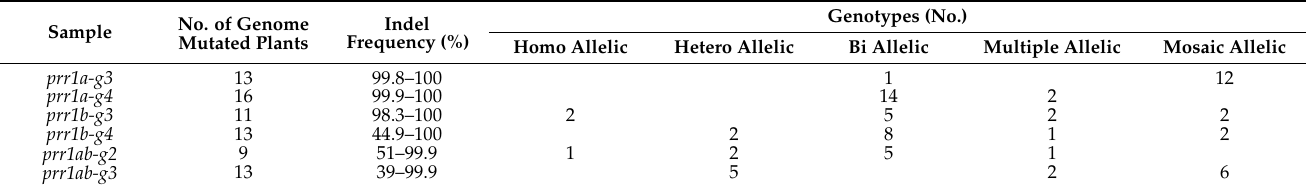
Table 3. Mutation frequencies of BrPRR1a and 1b genes in T 0 mutants of Chinese cabbage determined using the CRISPR/Cas9